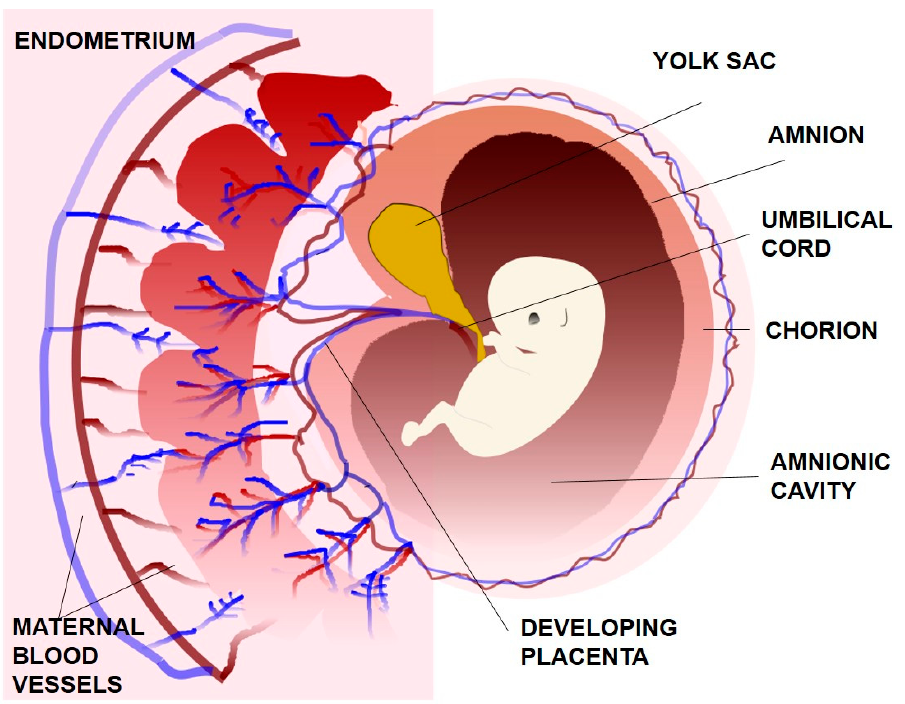
Figure 2 . The extraembryonic membranes. Figure 2. The extraembryonic